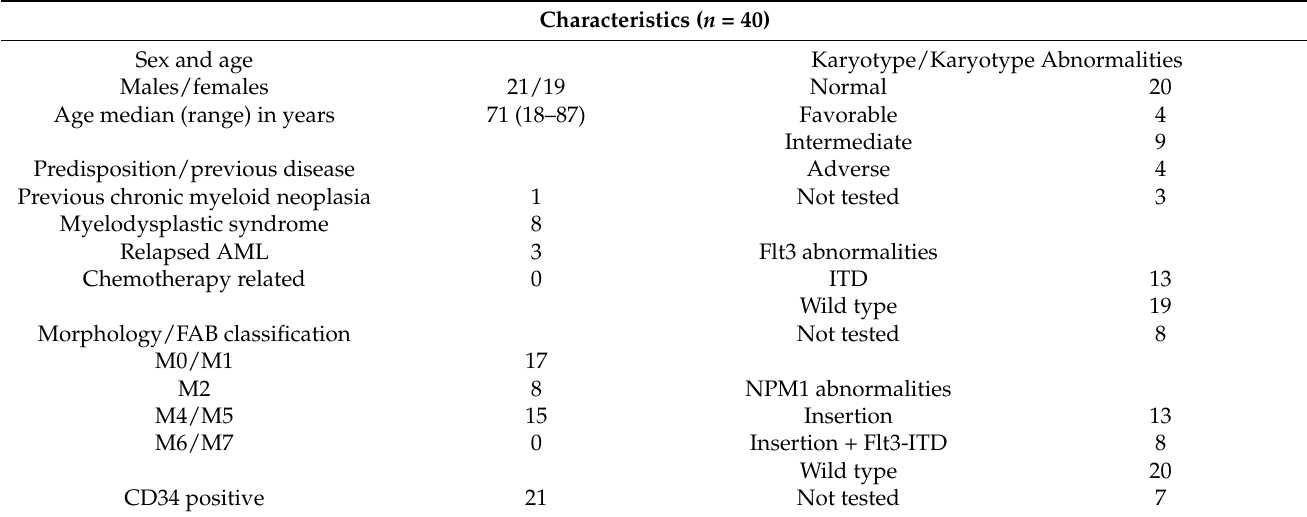
Table 1. Clinical and biological characteristics of the 40 AML patients included in this study. Unless otherwise stated, the results are presented as the number of